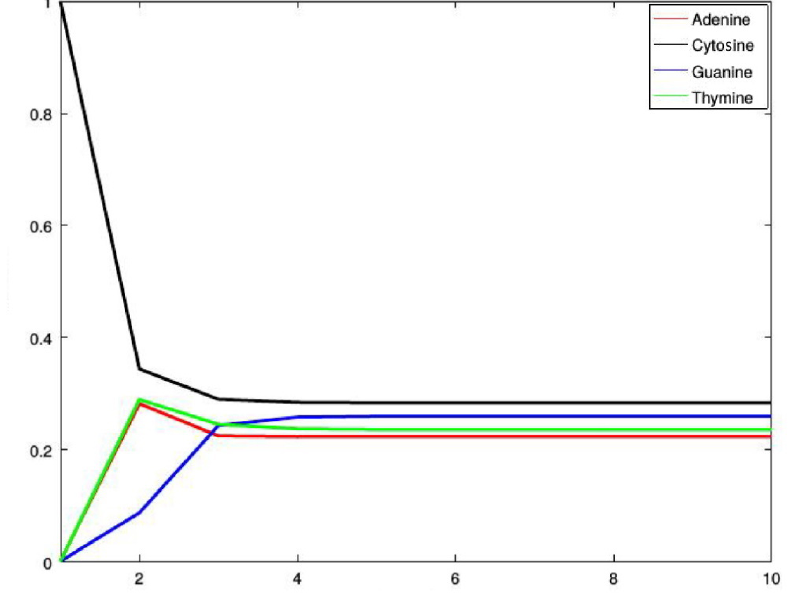
Figure 3. Probabilities of occurrences of the bases in consecutive steps starting from